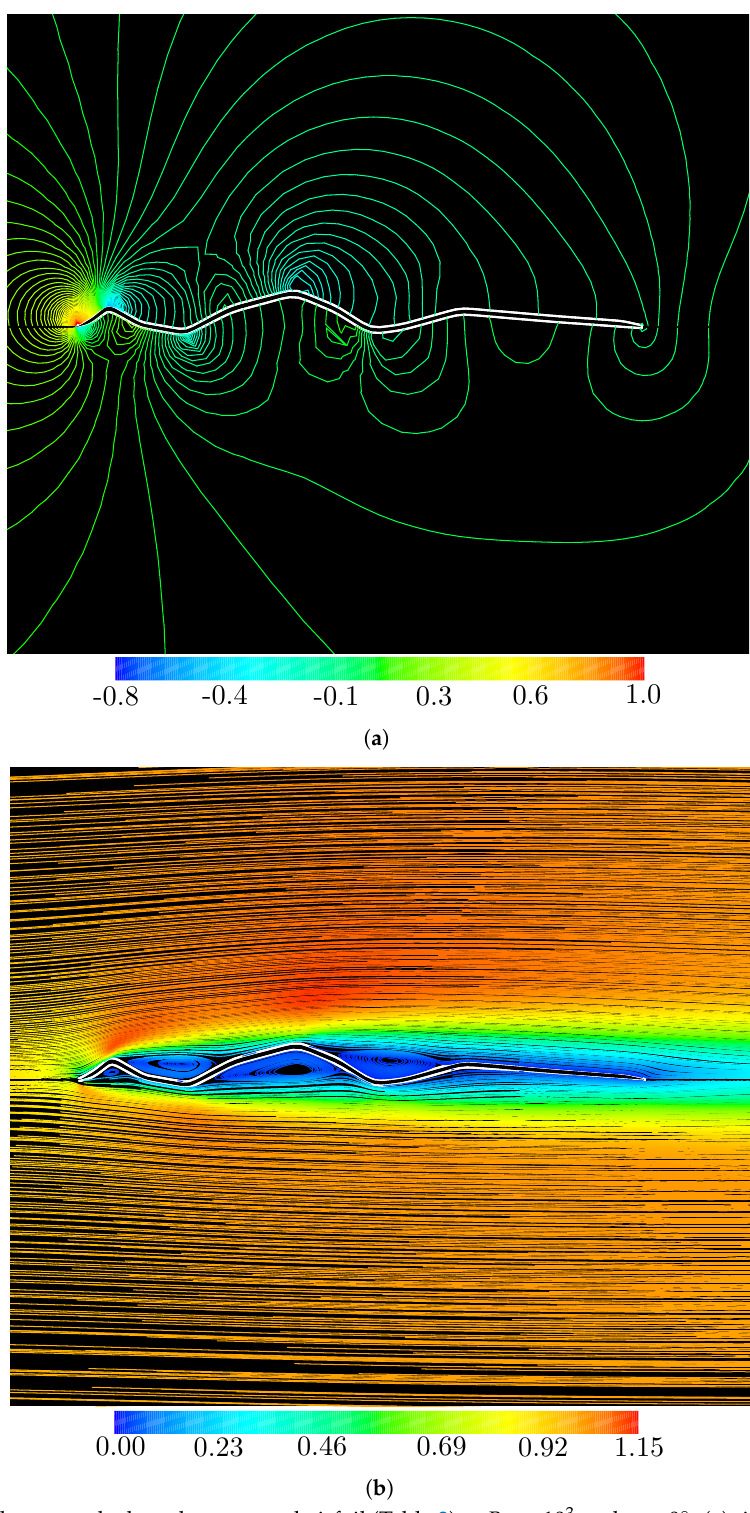
Figure 10. Flow past the based corrugated airfoil (Table 3) at Re = 10 3 and α = 0 ◦ : ( a ) time-averaged pressure isolines; and ( b ) time-averaged